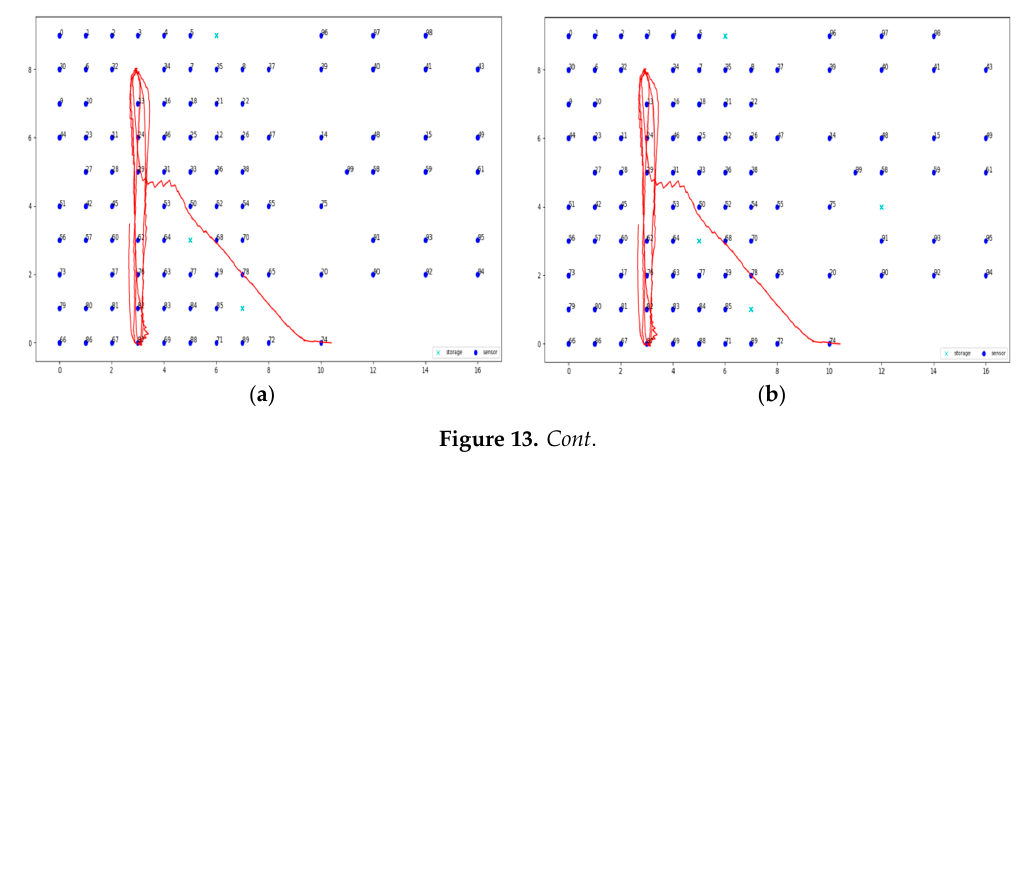
Figure 12. Evaluation results for dynamic clustering over the topology of 37 nodes for ( a ) 2 servers and square_1 trajectory, ( b ) 3 servers and square 1 trajectory, ( c ) 2 servers and h_line_2 trajectory, ( d ) 3 servers and h_line_2 trajectory. Table 2. Average privacy achieved by the DCA for the topology of 37 nodes. Table 1. Average privacy achieved by the walkthrough algorithm for the topology of 37 nodes.